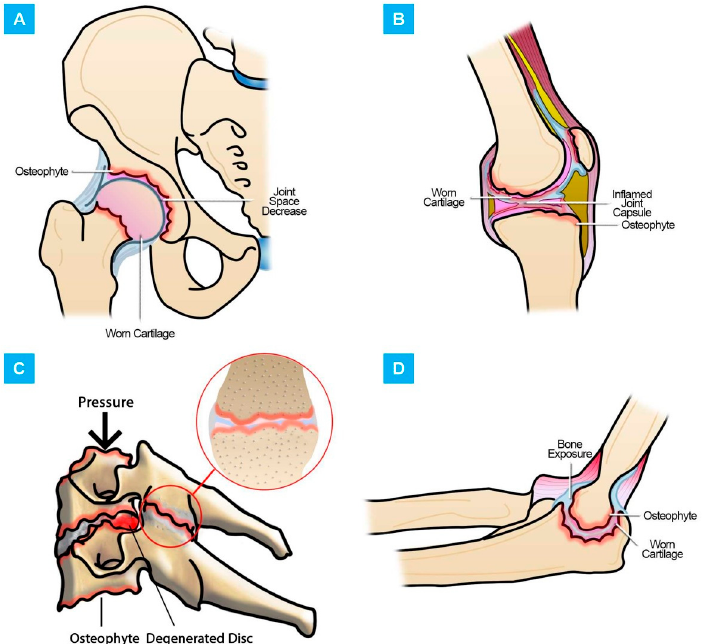
Figure 1. Damage explanation in the joints: ( A ) Hip osteoarthritis (OA); ( B ) knee OA; ( C ) facet OA; ( D ) elbow OA.